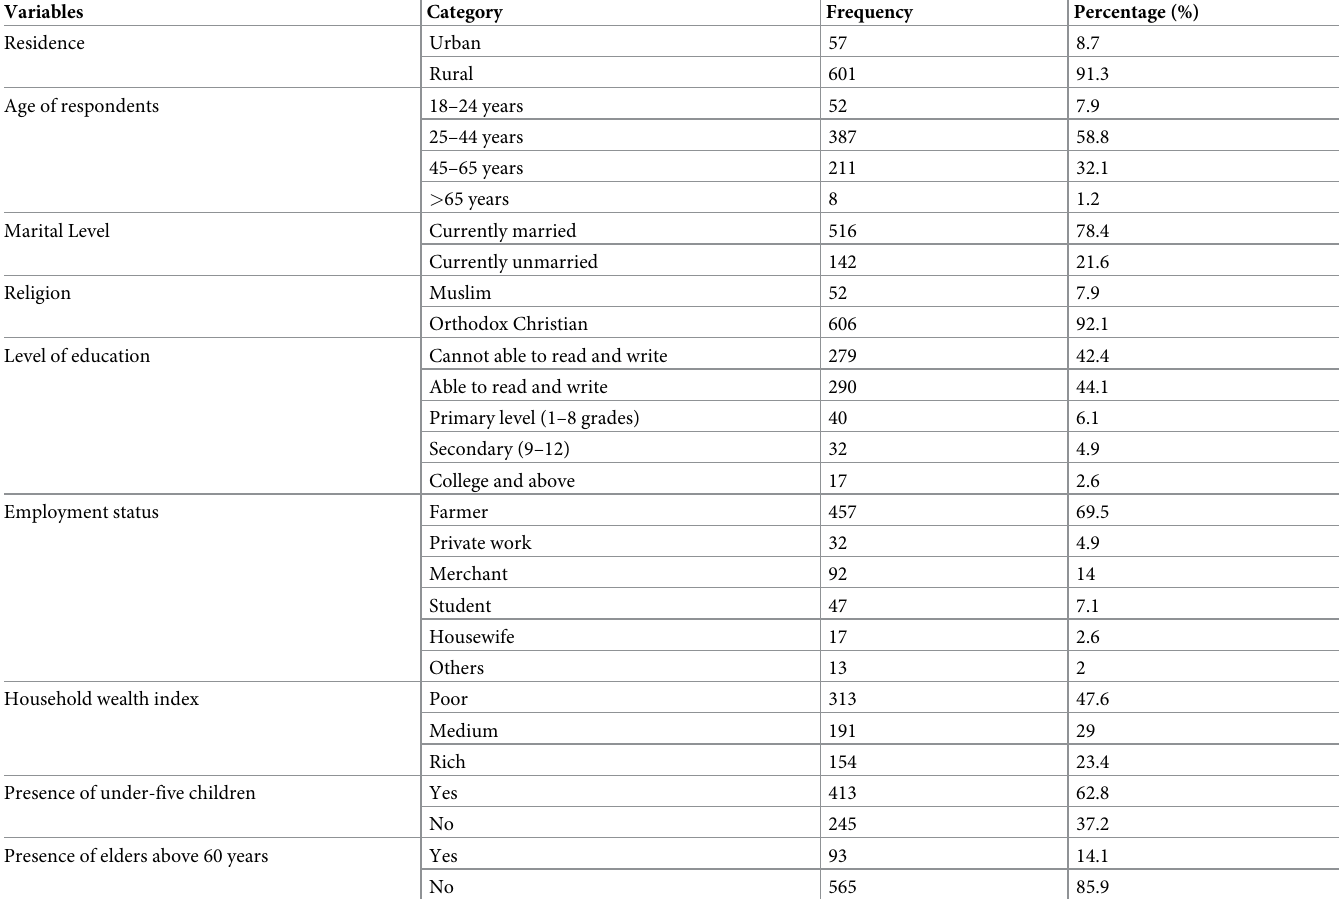
Table 1. Sociodemographic characteristics of respondents in South Gondar Zone, Northwest Ethiopia, 2021 (n = 658).